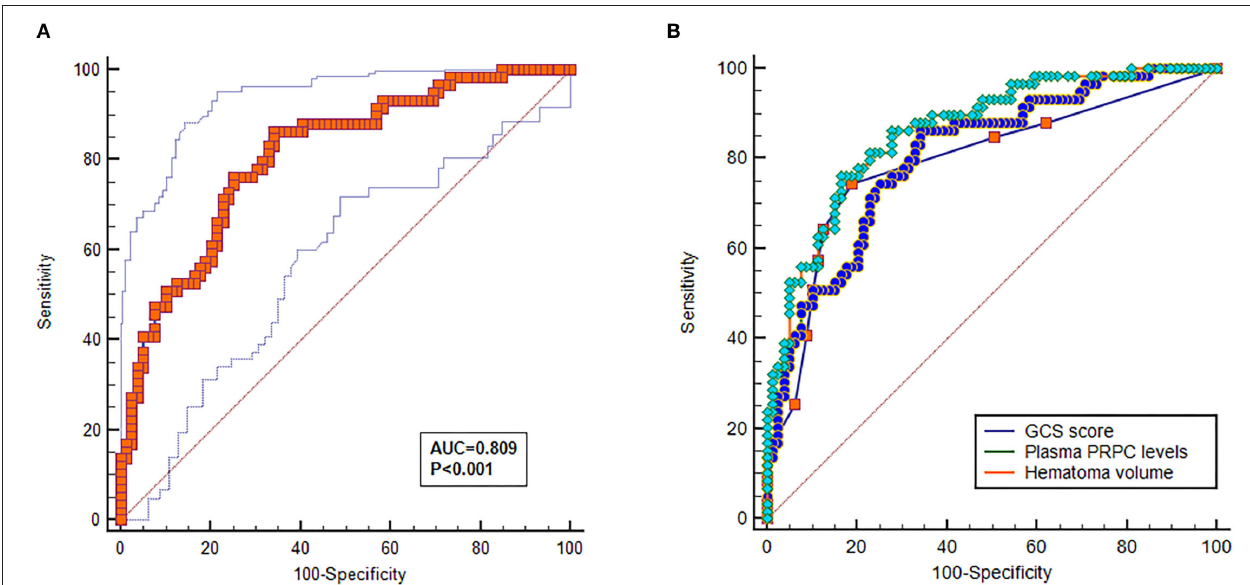
FIGURE 5 | Predictive value of plasma cellular prion protein levels for poor outcome at 90 days after intracerebral hemorrhage. (A) Discriminatory ability of plasma cellular prion protein levels for poor outcome at 90 days after intracerebral hemorrhage. Under the receiver-operating characteristic curve, plasma cellular prion protein levels remarkably predicted the poor outcome at 90 days after intracerebral hemorrhage (area under the curve, 0.809; 95% confidence interval, 0.737–0.881); and plasma cellular prion protein levels more than 3.893ng/ml distinguished patients with development of 90-day poor outcome with 86.4% specificity and 65.8% sensitivity, (Youden index J, 0.552). (B) Comparison of discriminatory capability with respect to plasma cellular prion protein levels, Glasgow Coma Scale score, and hematoma volume for 90-day poor outcome following acute intracerebral hemorrhage. Under receiver operating characteristic curve, prognostic predictive ability of plasma cellular prion protein levels (area under curve, 0.809; 95% confidence interval, 0.737–0.881) was similar to those of Glasgow Coma Scale score (area under curve, 0.793; 95% confidence interval, 0.716–0.857; P = 0.6462) and hematoma volume (area under curve, 0.863; 95% confidence interval, 0.795–0.916; P = 0.1062). Abbreviations: GOS, Glasgow Outcome Scale; PRPC, cellular prion